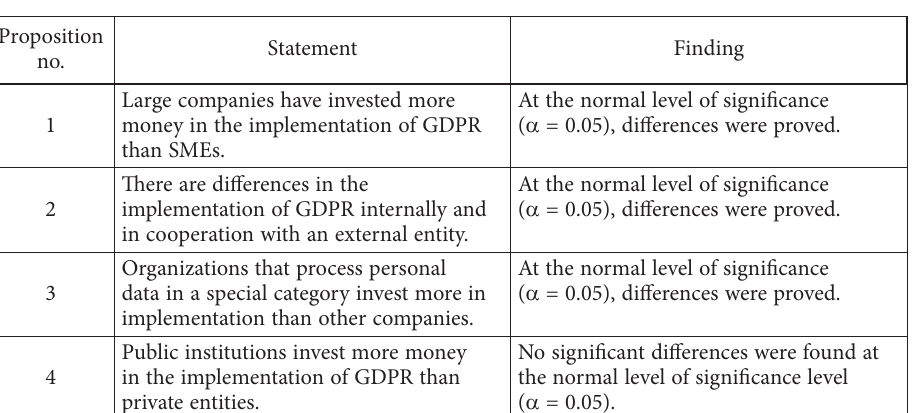
Table 4. Findings